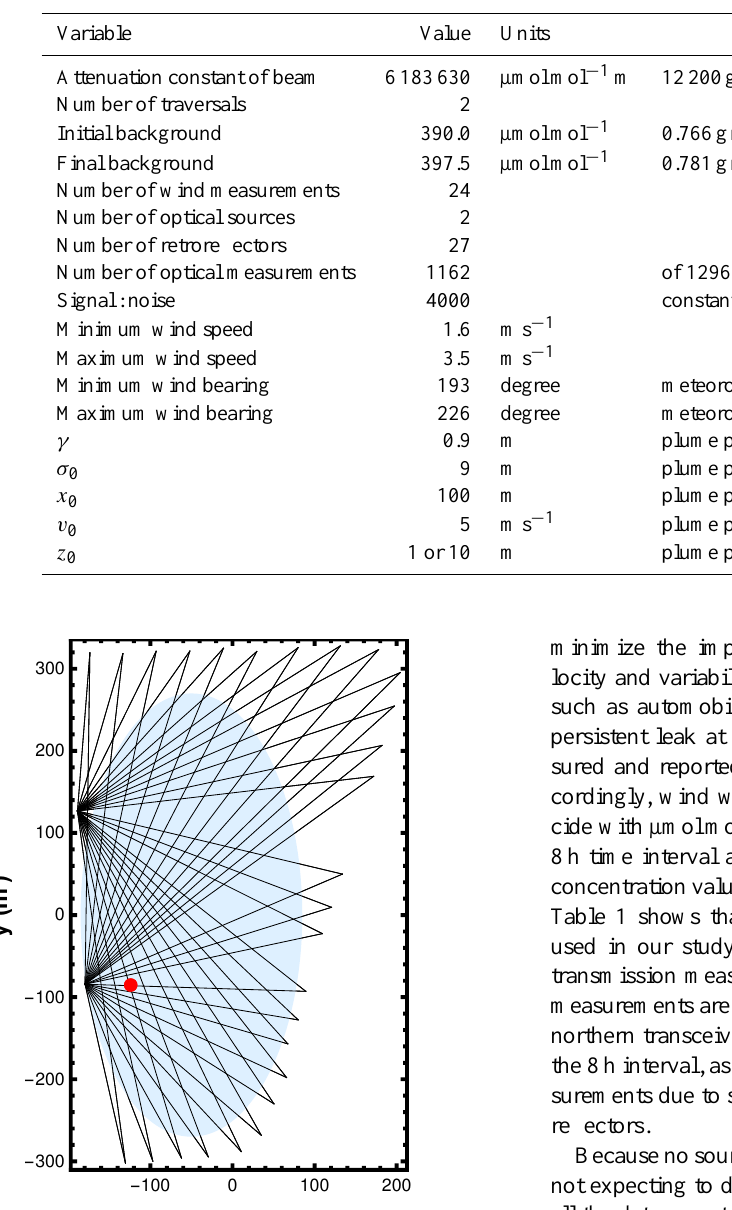
Table 1. Parameters used in the calculation. Units are omitted for dimensionless quantities.